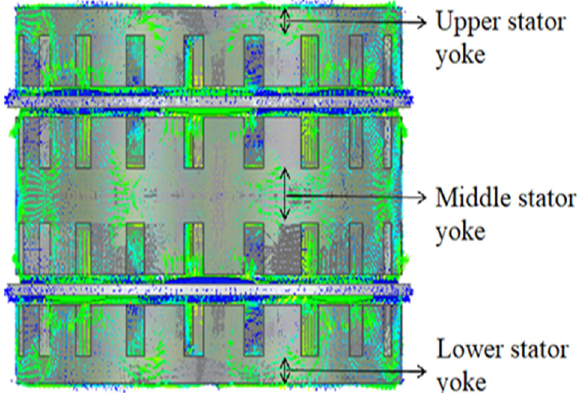
Figure 3. Flux lines in the magnetic circuit of the proposed generator .